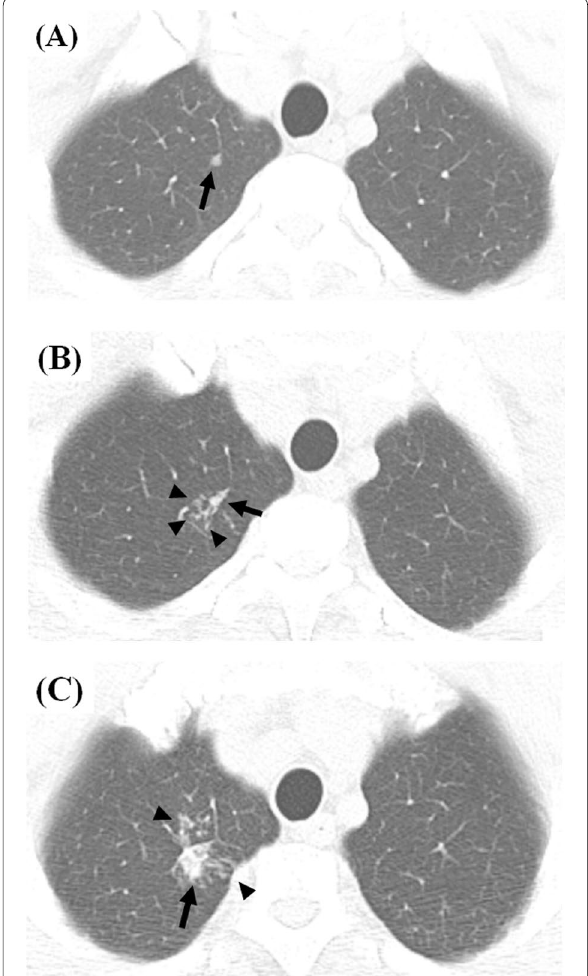
Fig. 2 Representative CT images showing incipient TB progressing into active tuberculosis disease in a 52‑year‑old healthy male. a A screening CT image shows a small single incidental nodule in the right upper lobe (black arrow). b A follow‑up CT image 20 months later reveals a few additional micronodules (black arrowheads) in a secondary pulmonary lobule around the small pre‑existing nodule (black arrow). The patient denied any symptoms and signs and had negative sputum smear and culture tests. c The next follow‑up CT image 24 months later shows the increasing size and number of the nodule (black arrow) and micronodules (black arrowheads) in the right upper lobe. The patient still denied any symptoms and signs. The sputum smear was negative, and Mycobacterium tuberculosis was confirmed on sputum culture. The patient had a 6‑month standard anti‑tuberculosis medication and healed without